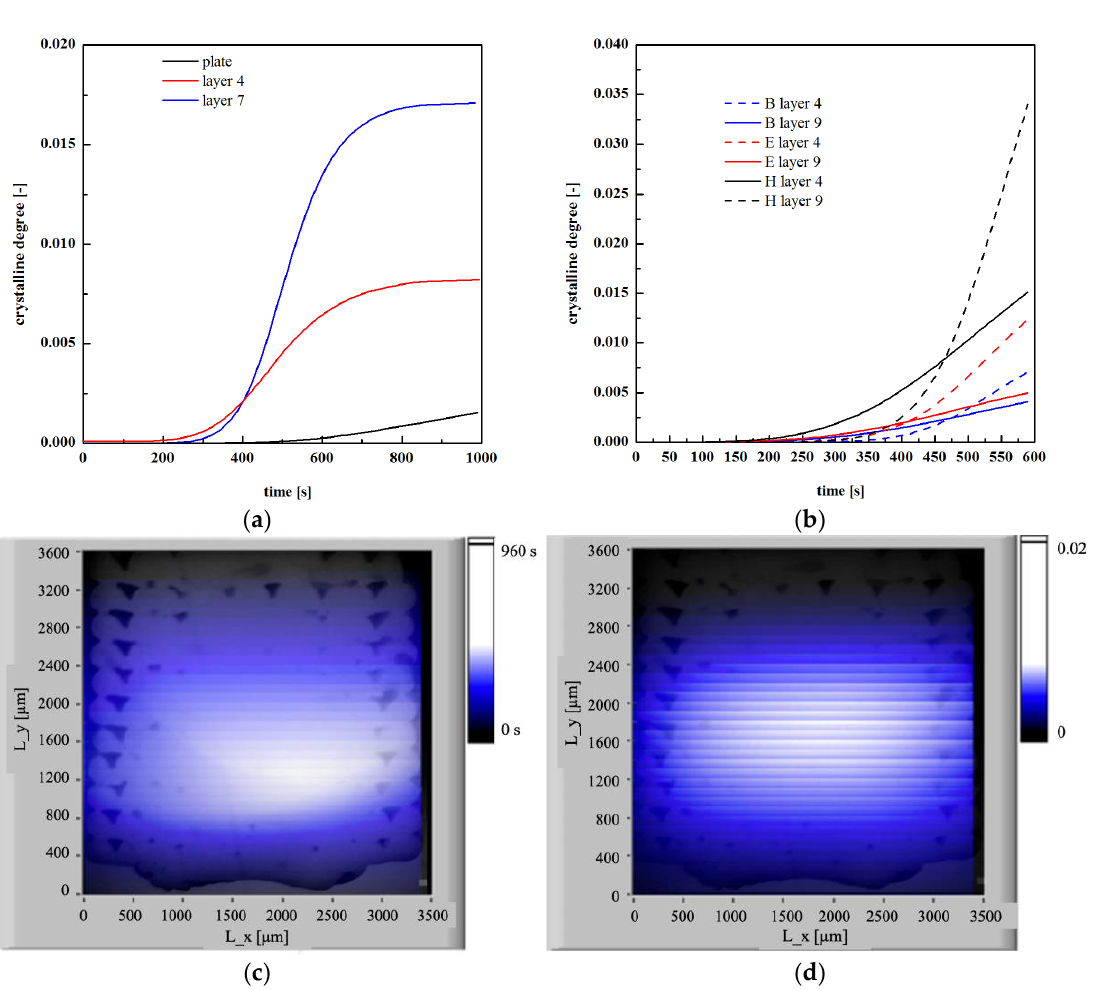
Figure 16. ( a ) Crystallinity evolutions of different layers for the case E evaluated by simulation; ( b ) crystallinity degree evaluated at layer 4 and layer 9 for the cases B, E and H; ( c ) time the molecules spend above 90 ◦ C for the case E; ( d ) crystallinity measured after 1000 s for the case E. The optical micrograph of the specimen E is also embedded in the